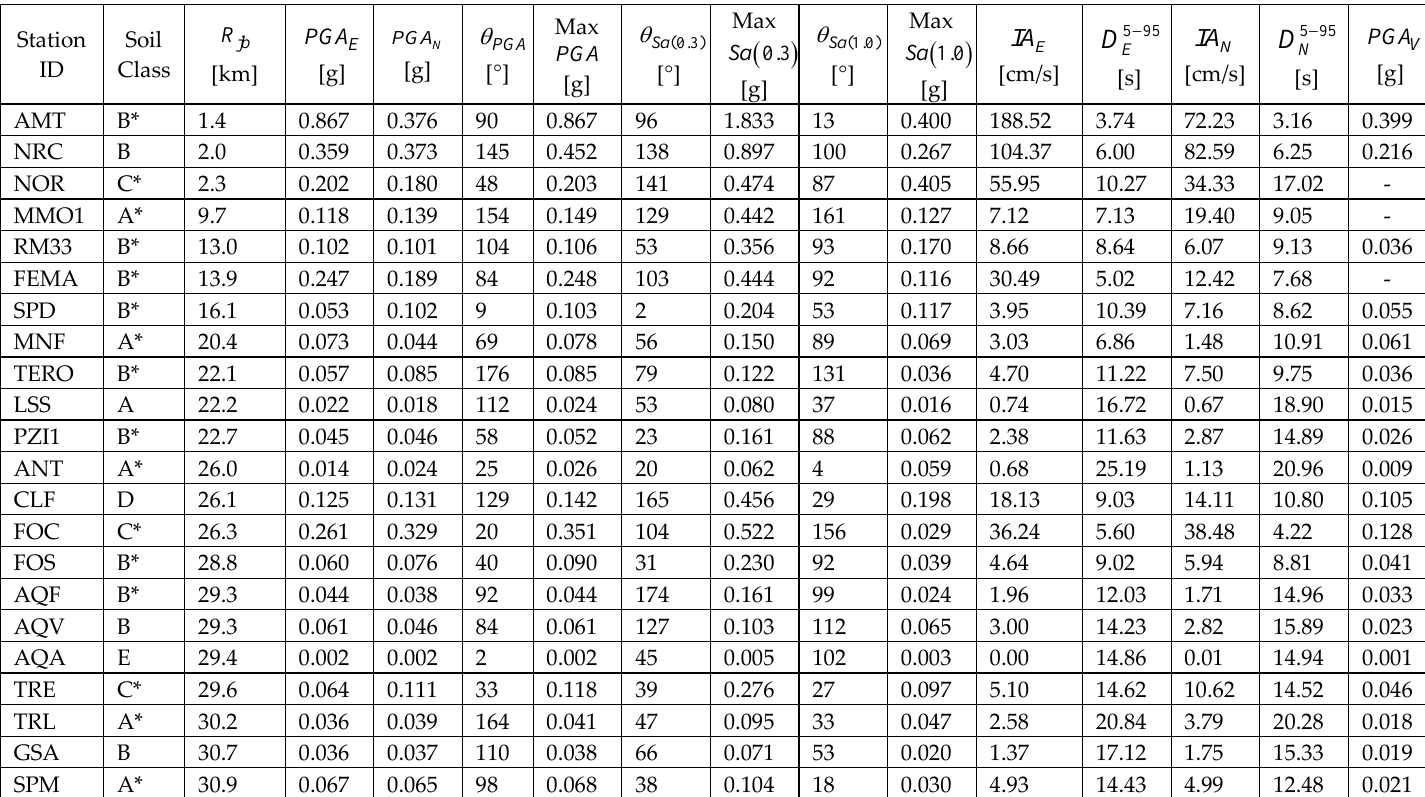
Table 1. IMs of the recorded ground motions within 30 km from the source (distance in terms of jb R